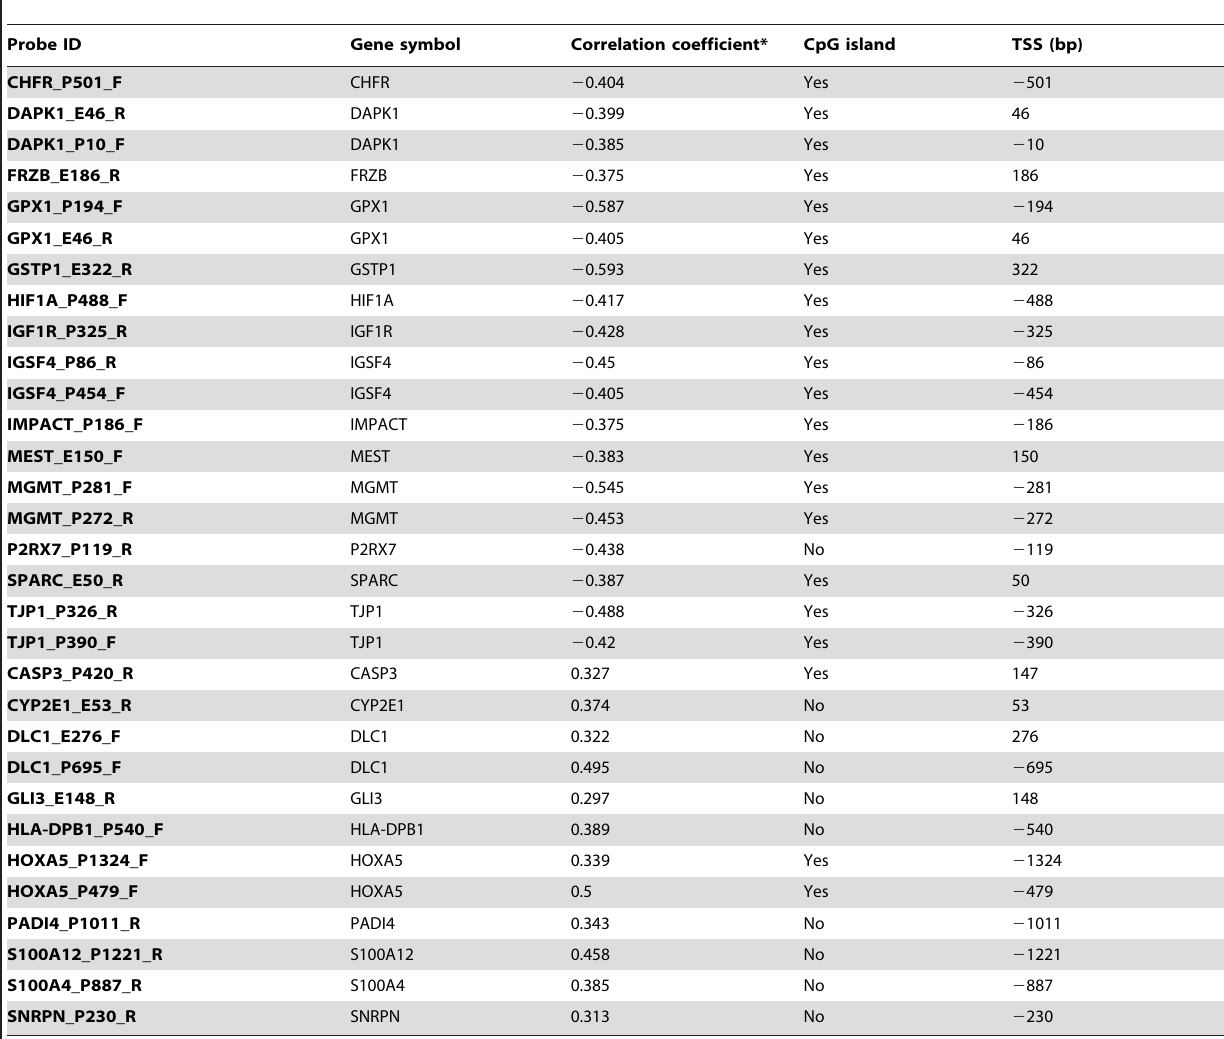
Table 2. CpG loci with statistically significant methylation-expression relationships as determined by Pearson correlation.